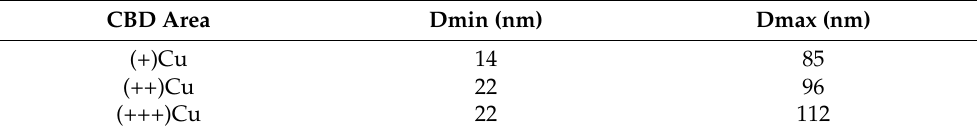
Table 1. Aggregates’ minimum (Dmin) and maximum (Dmax)